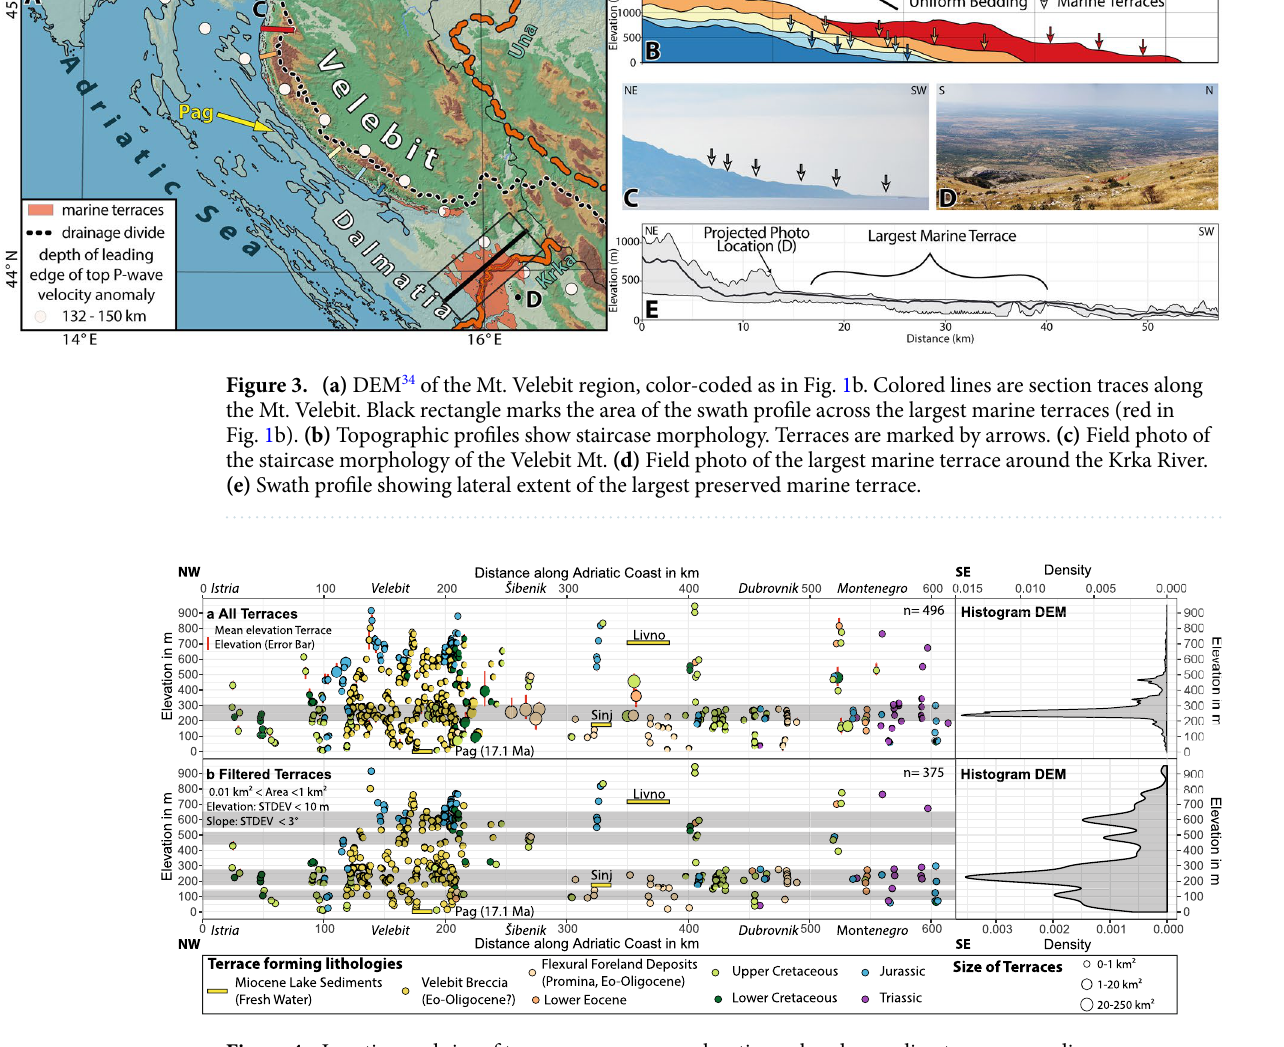
Figure 4. Location and size of terraces versus mean elevation colored according to corresponding lithostratigraphic units. Position and present-day elevation of the Miocene basins are shown; for exact location see Fig. 1b. (a) Dataset of all extracted terraces with corresponding histogram of the terrace elevation. (b) Filtered dataset showing only terraces > 0.01 km 2 and < 1 km 2 , and those that have an elevation standard deviation of less than 10 m and a slope standard deviation of less than